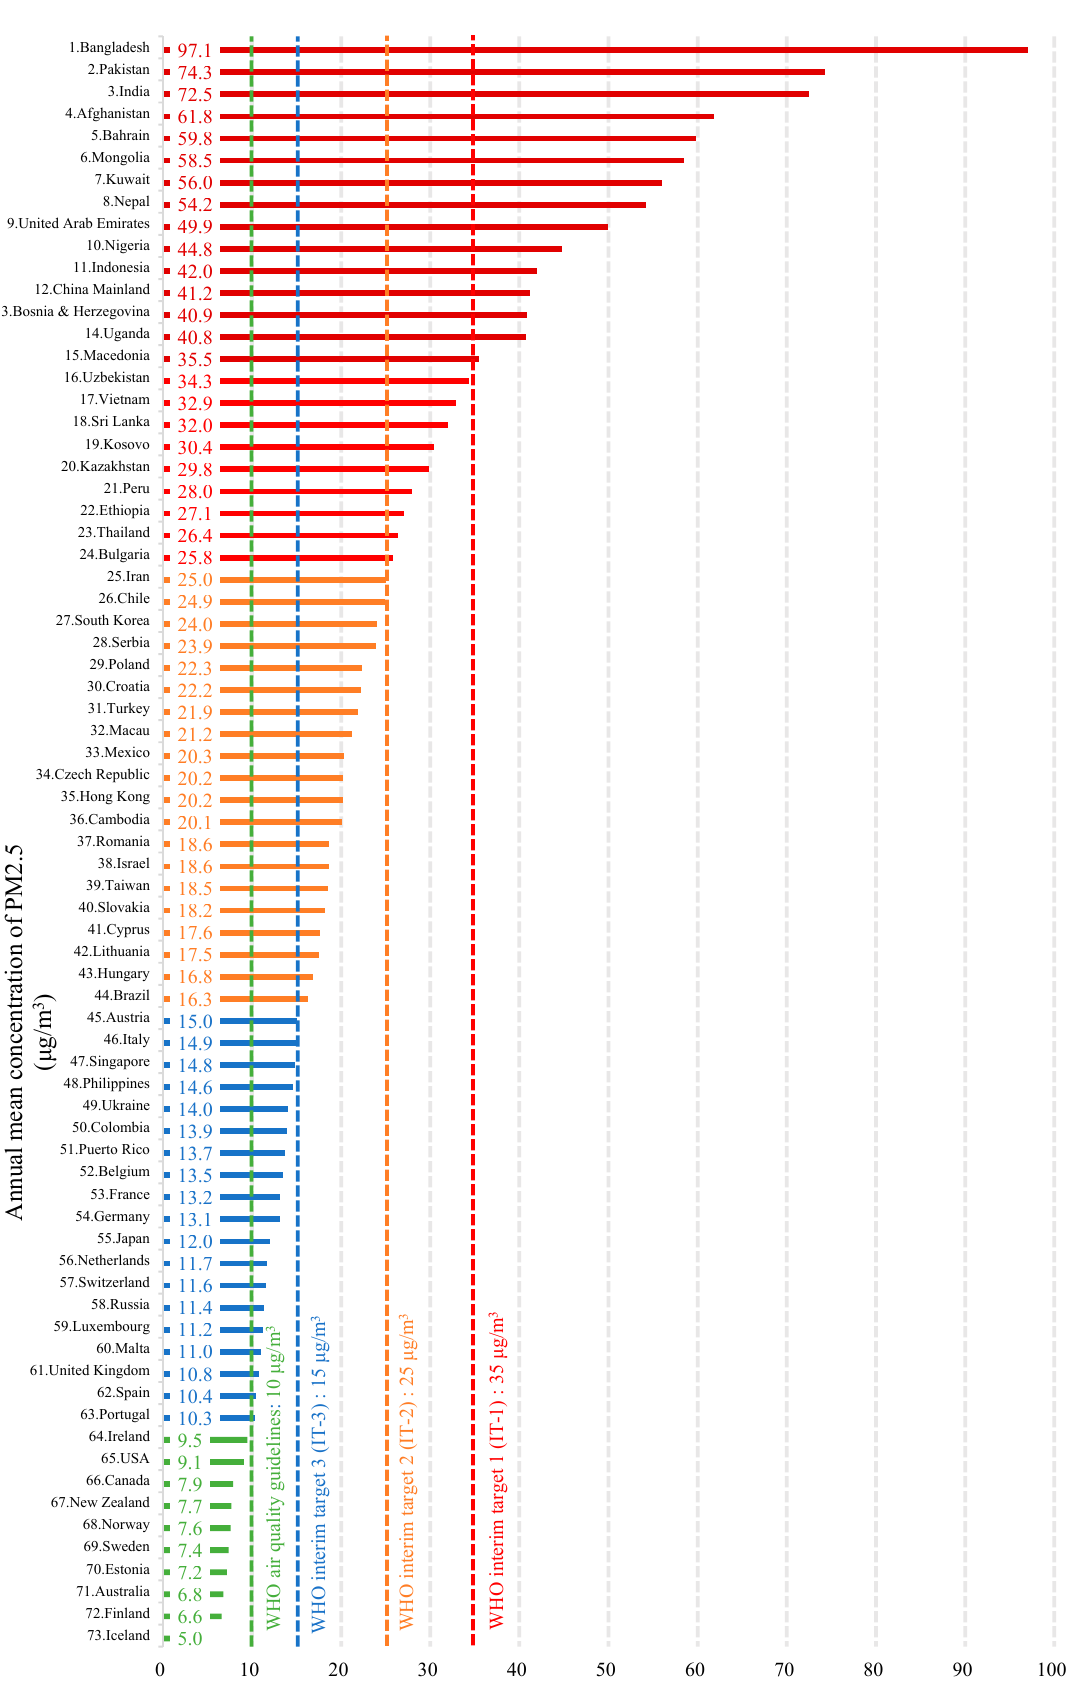
Figure 1. Outdoor particulate matter (PM2.5) pollution in 73 regions, in 2018